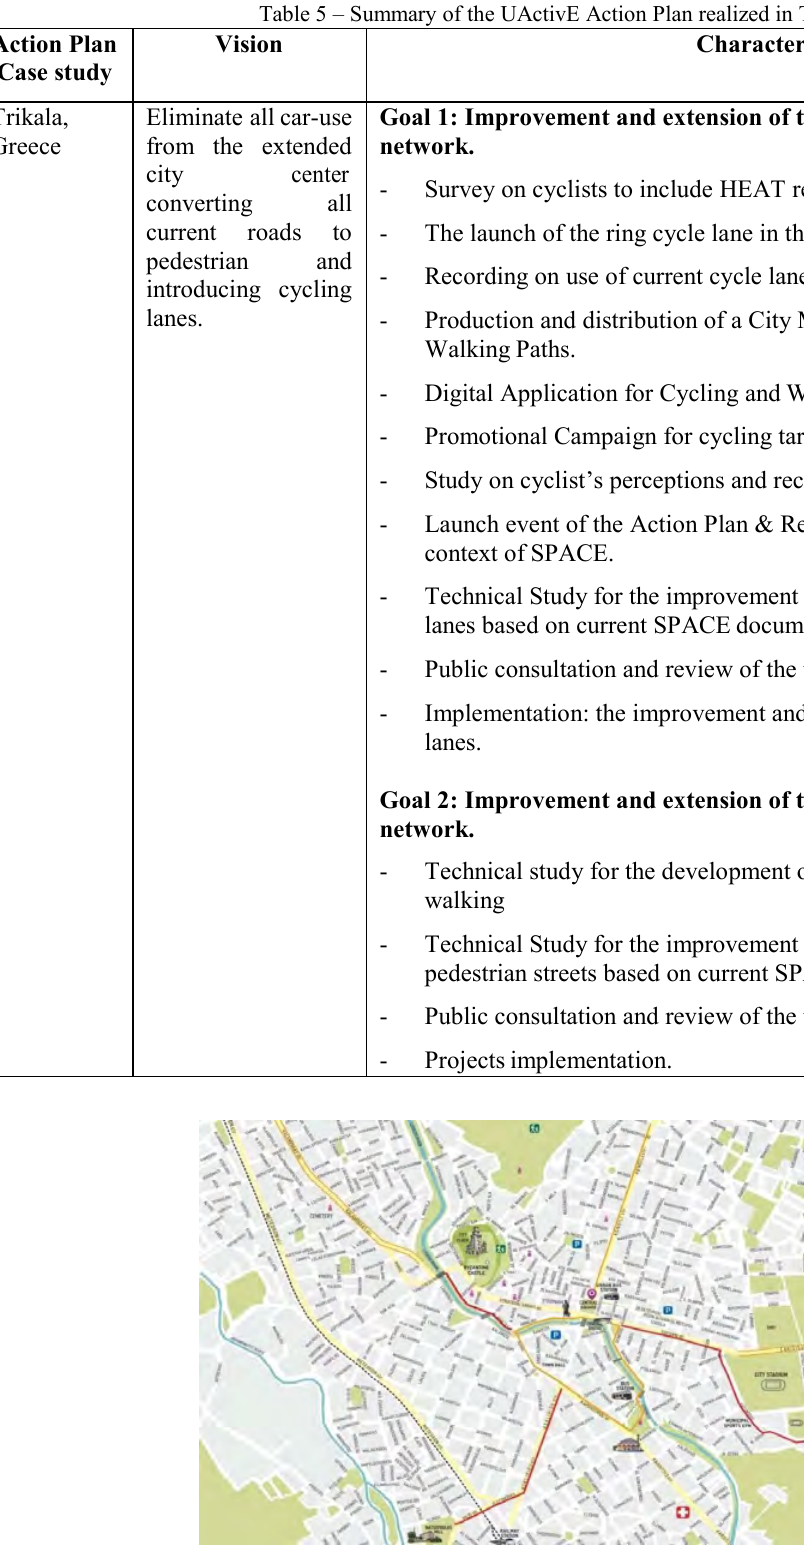
Figure 5 – Bike lanes in Trikala